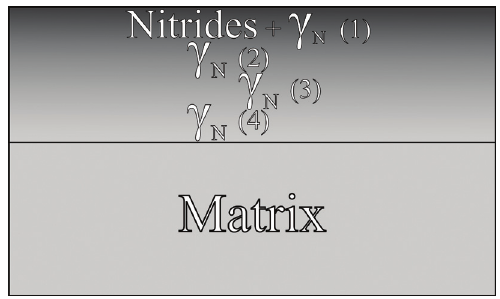
Figure 4. Illustration of the subpeaks used for the g N Table 2. Values for Lattice parameter ( a ), Distortion ( η ) and Nitrogen concentration ( C ) for each sublayer of the g phases used N N in DRX pattern fittings for samples nitrided at 350 °C.